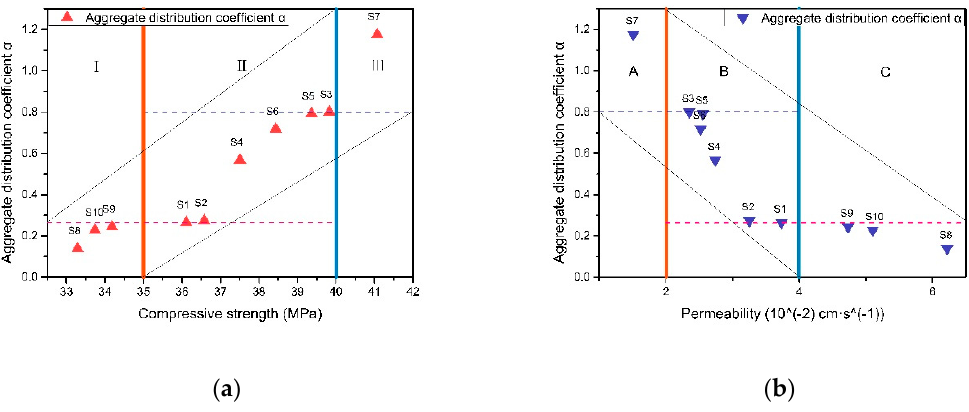
Figure 14. RBPB’s macro performance area division. ( a ). Relationship between compressive strength and aggregate distribution coefficient α . ( b ). Relationship between permeability and aggregate distribution coefficient α .